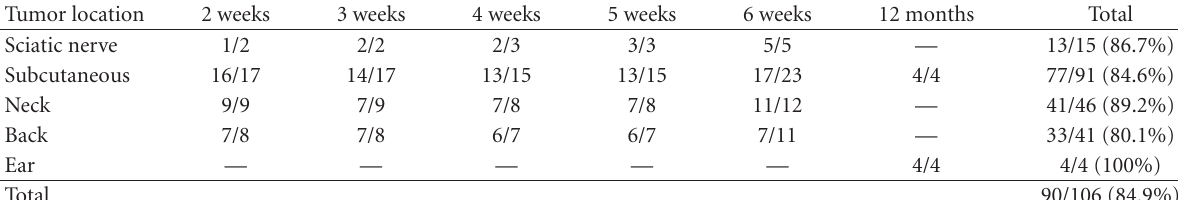
Table 1. Survival of human neurofibroma xenografts in di ff erent locations of SCID mice, without therapy. Tumor location